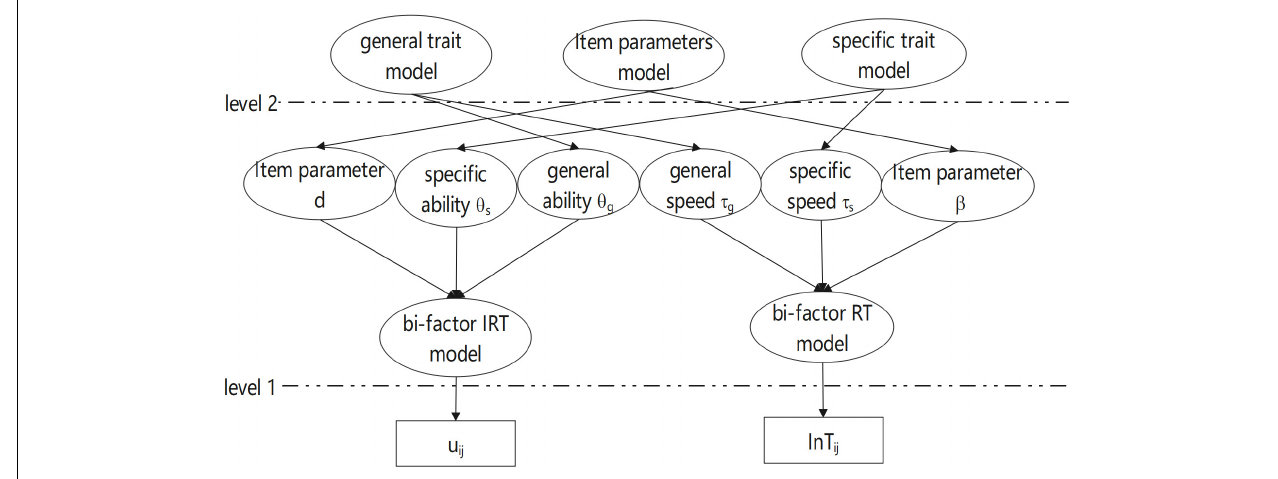
FIGURE 1 | A bi-factor hierarchical model in between-item multidimensional